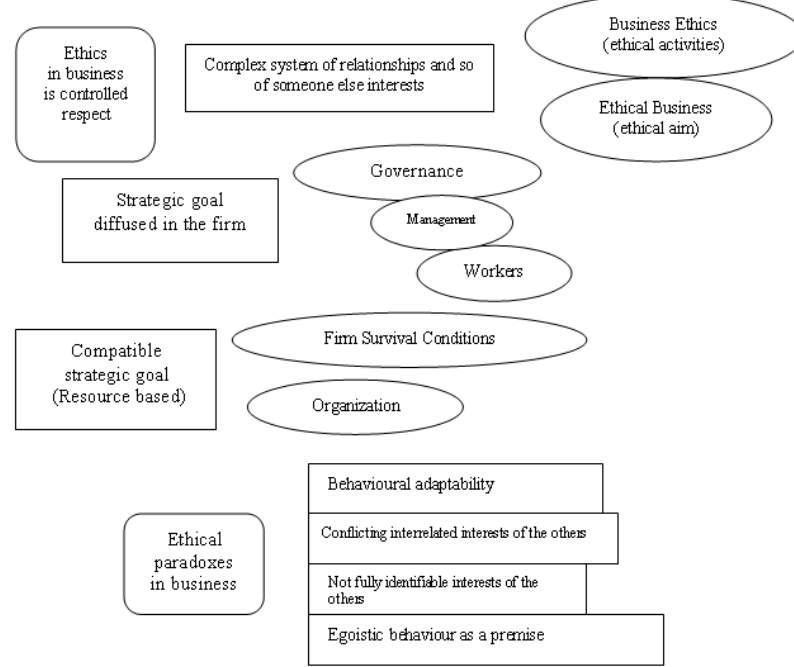
Figure 1: Synthetic Framework of Ethics in